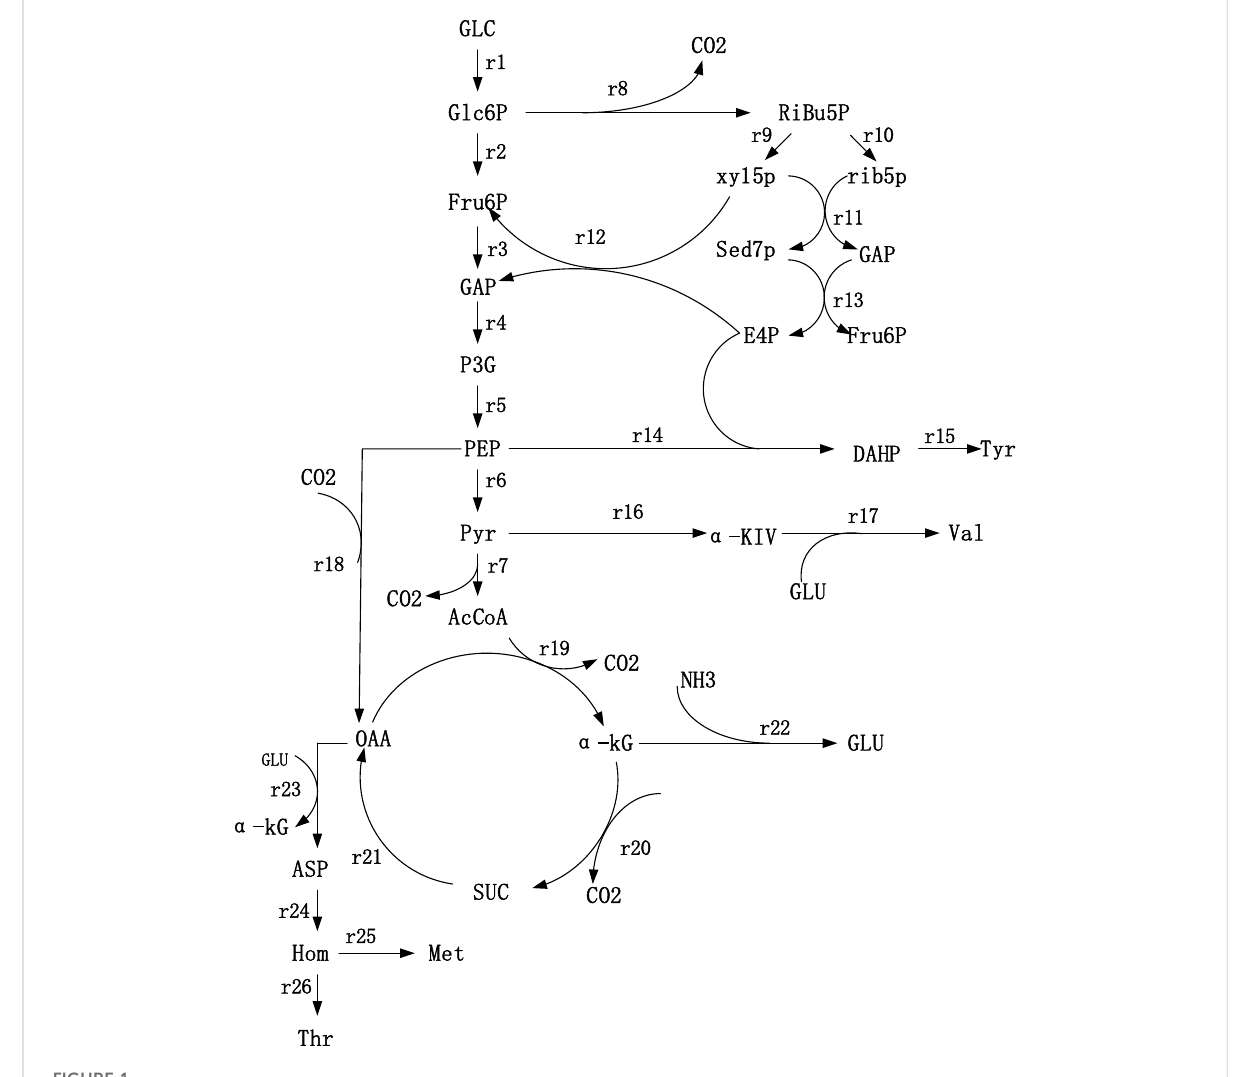
FIGURE 1 Metabolic network of Thr synthesis. 1) Glc: Glucose; 2) Glc6P: Glucose-6-phosphate; 3) PEP: Phosphoenolpyruvate; 4) Pyr: Pyruvate; 5) Fru6P: Fructose- 6-phosphate; 6) GAP: Glyceradehyde-3-phosphate; 7) P3G: 3-phosphoglycerate; 8) AcCoA: AcetylcoenzymeA; 9) Ribu5P: Ribulose-5- phosphate; (10) Xyl5P: Xylulose-5-phosphate; 11) Rib5P: Ribose-5-phosphate; 12) Sed7P: Sedoheptulose-7-phosphate; 13) E4P: Erythrose-4- phosphate;14)OAA:Qxaloacetate;15) α -KG: α -ketoglutarate;16)NADPH:Nicotinamideadeninedinu-cleotidephosphate;17)Glu:Glutamate; 18) α Kiv: α -ketoisovalerate; 19) Asp: Aspartate; (20) Hom: Homoserine; 21) DAHP: